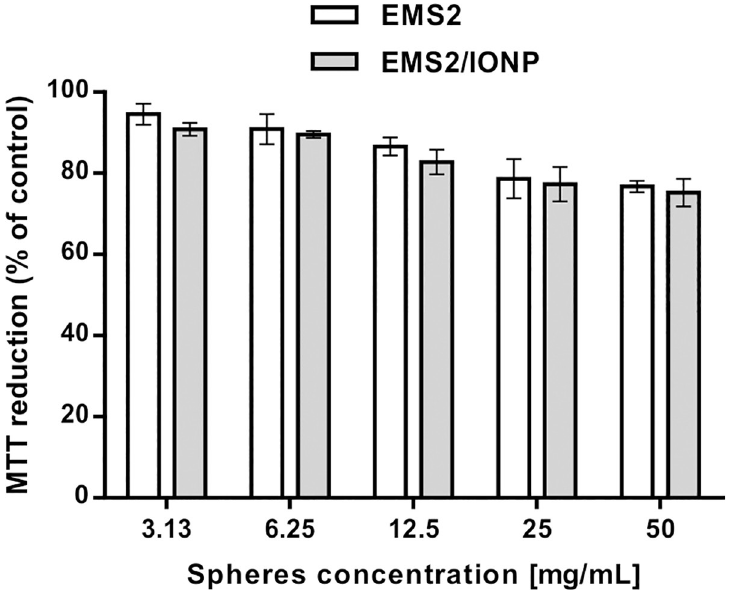
Fig 8. Cytotoxicity study by MTT assay. The NIH3T3 fibroblasts were cultured in the presence of EMS2 and EMS2/ IONP spheres for 72 h. Spheres were produced using an initial silk concentration of 1 mg/mL and 2 M potassium phosphate (pH 8) in the presence or absence of IONPs. The MTT reduction was calculated with reference to the non- treated cells. Error bars show the standard deviations of the mean of three independent experiments.